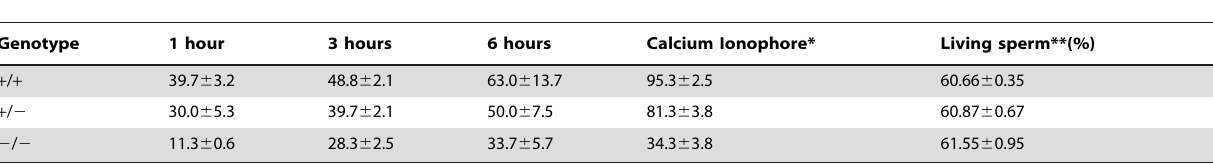
Table 2. Acrosome